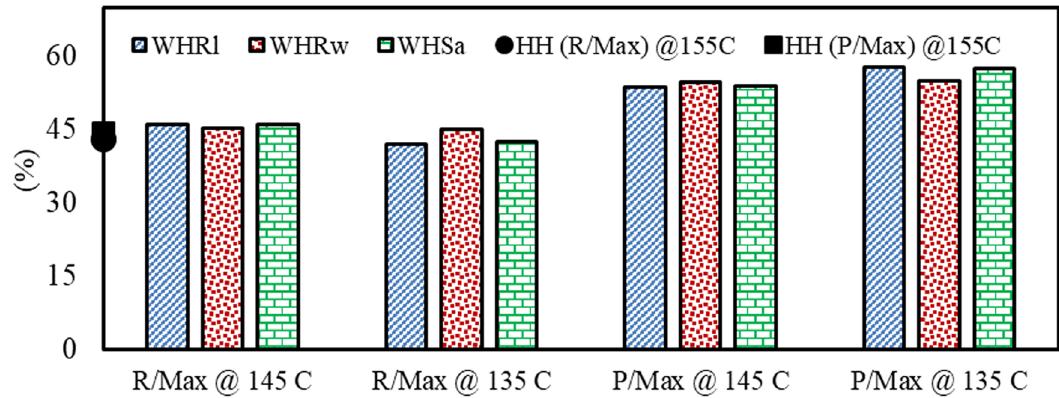
Figure 16: Final percentages of recovered and permanent strain at the termination of the third cycle of MSCR.